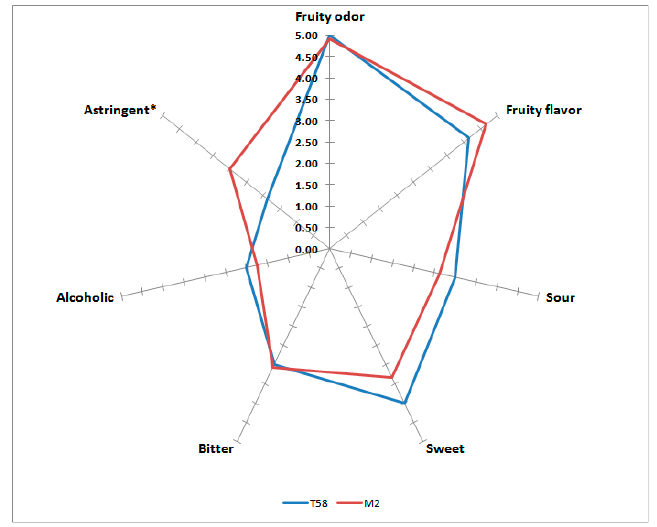
Figure 5. Radar plot of the mean rating scores for the T58 and M2 beers. (*) denote samples that were significantly different ( p ≤ 0.05).